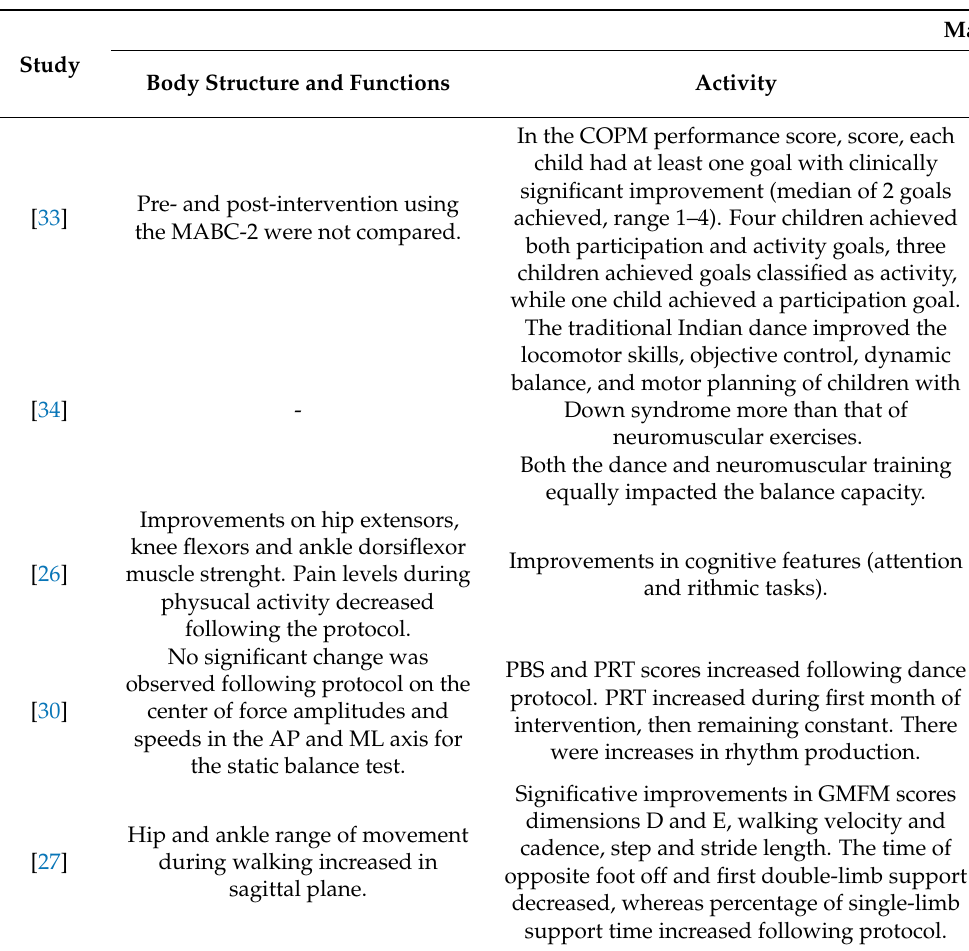
Table 3. Reported outcomes on intervention group, according to the